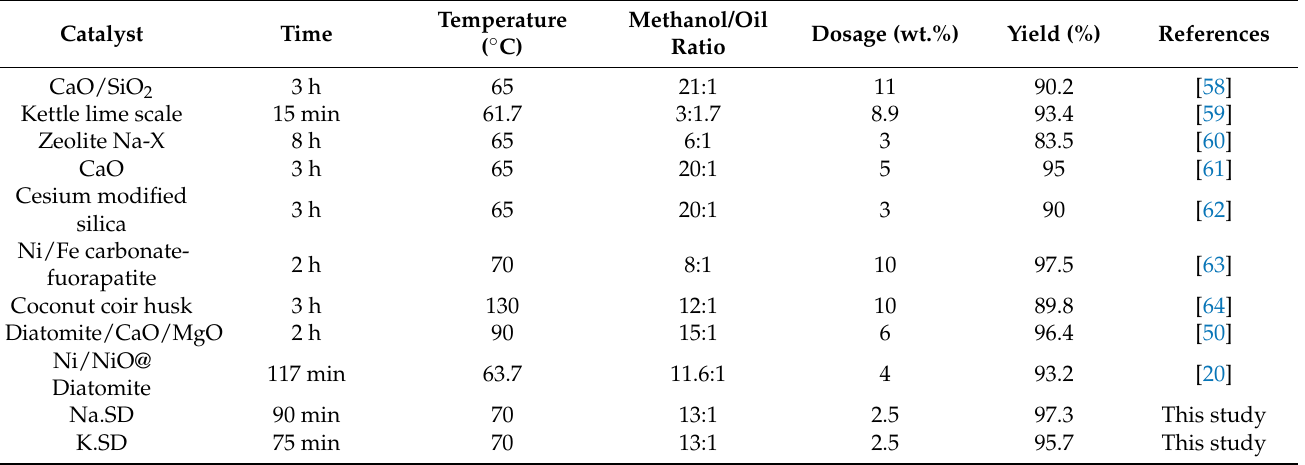
Table 6. Comparison between the obtained biodiesel yield using Na.SD and K.SD catalysts and other catalysts in the